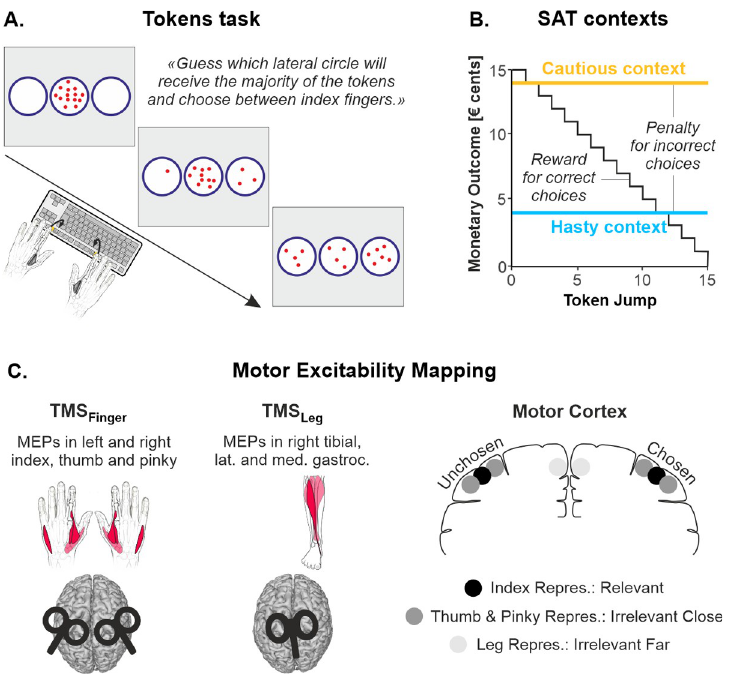
Fig 1. Tokens task, SAT contexts, and motor excitability mapping. (A) Tokens task. Participants had to choose between left or right index finger key presses depending on which lateral circle they thought would ultimately receive the majority of the tokens. (B) SAT contexts. The reward provided for correct choices decreased over the course of the trial, producing an increasing urge to decide. Most importantly, the use of a low penalty ( − 4 cents; blue) promoted hasty choices (hasty context), while a high penalty ( − 14 cents; yellow) fostered cautious choices (cautious context). In both contexts, a low penalty ( − 4 cents) was provided when participants did not respond before Jump 15 (not represented here). (C) Motor excitability mapping (related to S1 Fig). Left: In TMS Finger participants, a double-coil approach allowed us to elicit MEPs in index, thumb, and pinky muscles of both hands. In TMS Leg participants, MEPs were recorded in 3 right leg muscles. MEPs recorded in these 9 muscles were of reliable amplitude and were reproducible across sessions (see S1 Fig). Right: MEPs obtained in these different muscles allowed us to quantify excitability changes associated with a choice-relevant motor representation (i.e., the index finger representation), choice-irrelevant representations that lie close by the choice-relevant one (i.e., the thumb and pinky representations), and choice-irrelevant representations that lie far from the choice-relevant one (i.e., the leg representations). Further, classifying MEPs according to whether they fell on the same side as the chosen index or on the side of the unchosen index allowed us to measure excitability of the motor system on both the chosen and the unchosen side. M AU : AbbreviationlistshavebeencompiledforthoseusedthroughoutFigs 1 (cid:0) 7 andTable 1 : Pleaseverifythatallentriesarecorrect : EP, motor- evoked potential; SAT, speed–accuracy trade-off; TMS, transcranial magnetic